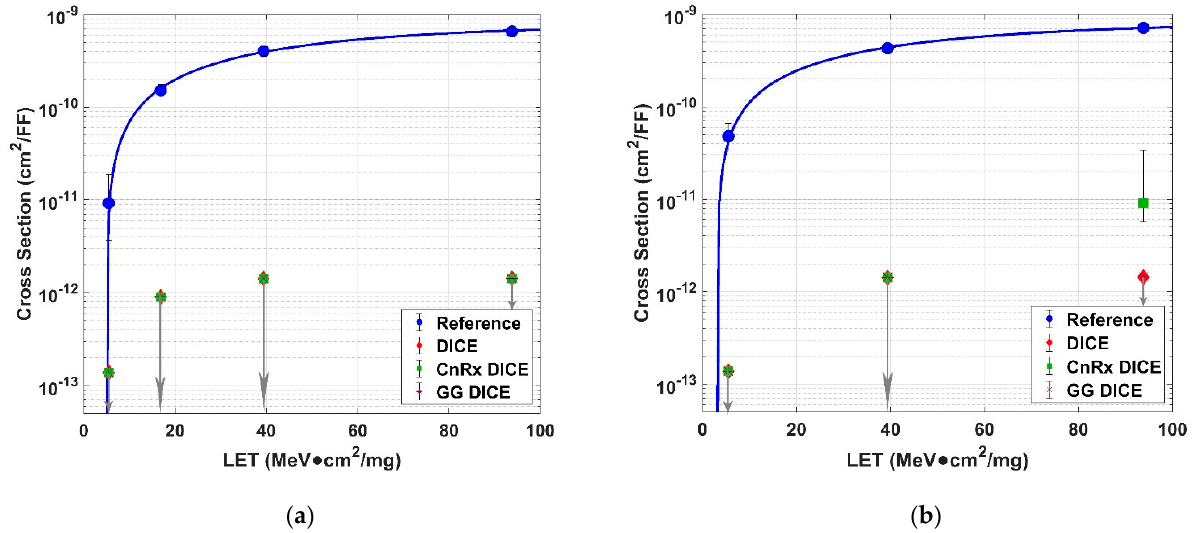
Figure 10. Cross − sectional values for heavy ion testing at a 60° incidence angle from normal. ( a ) Core voltage of 0.8 V, ( b ) core voltage of 0.6 V.